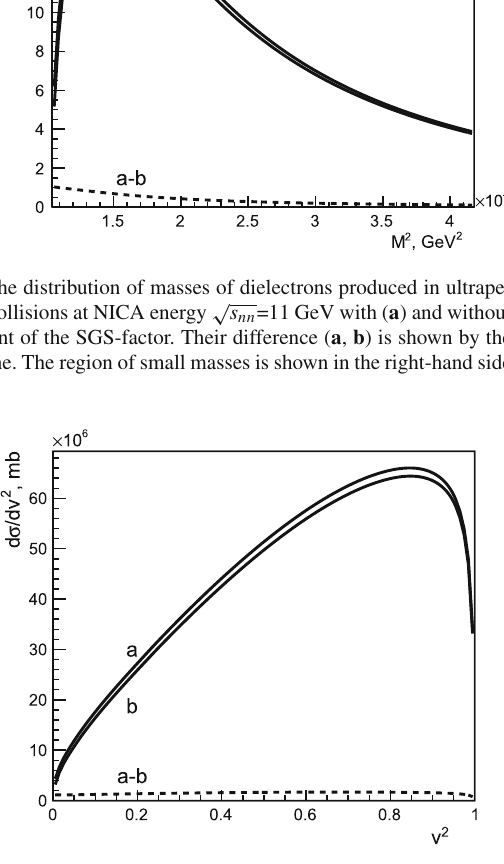
Fig. 2 The distribution of the relative velocities in dielectrons pro- duced in ultraperipheral collisions at NICA energy ( a ) and without ( b ) account of the SGS-factor. Their difference ( a , b ) is